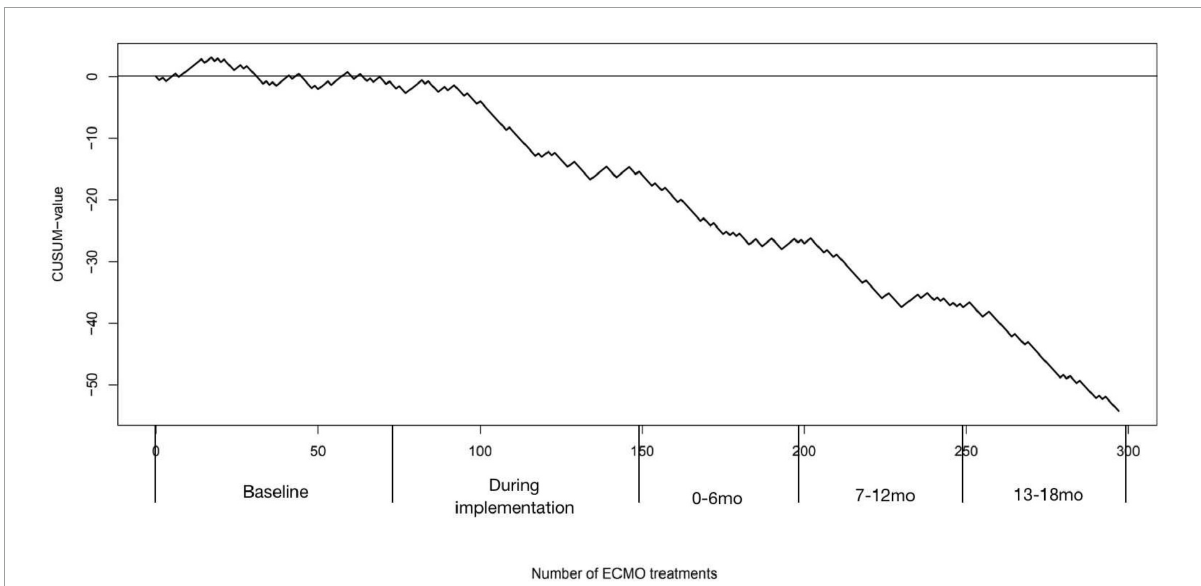
FIGURE4 Cumulative observed minus failure (CUSUM) chart for in-hospital mortality after extracorporeal membrane oxygenation (ECMO) treatment. The vertical axis shows the CUSUM value, which increases for each failure or decreases on each success. The horizontal axis shows the number of ECMO treatments and the corresponding period. An upward slope represents a failure rate higher than expected and a downward slope represents a failure rate fewer than